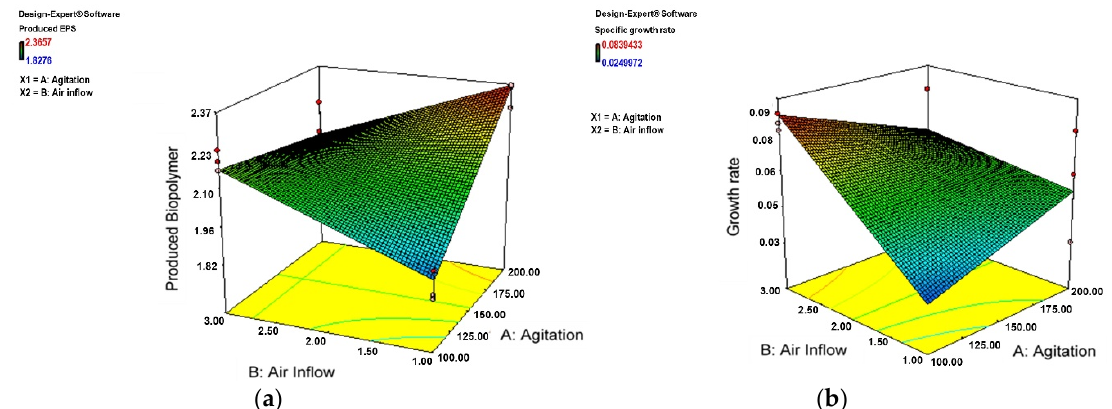
Figure 3. Interactions of agitation and air inflow over biofilm production ( a ) and growth rate ( b ).